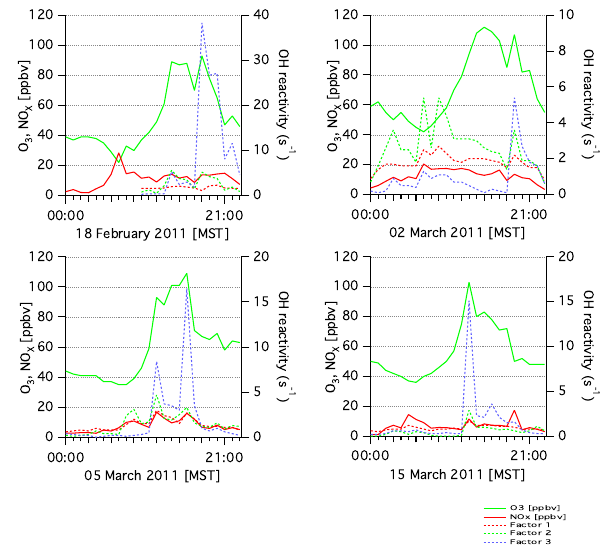
Figure 10. Relationship of PMF factor OH reactivity, NO x and O 3 during selected episodes at Boulder South Road